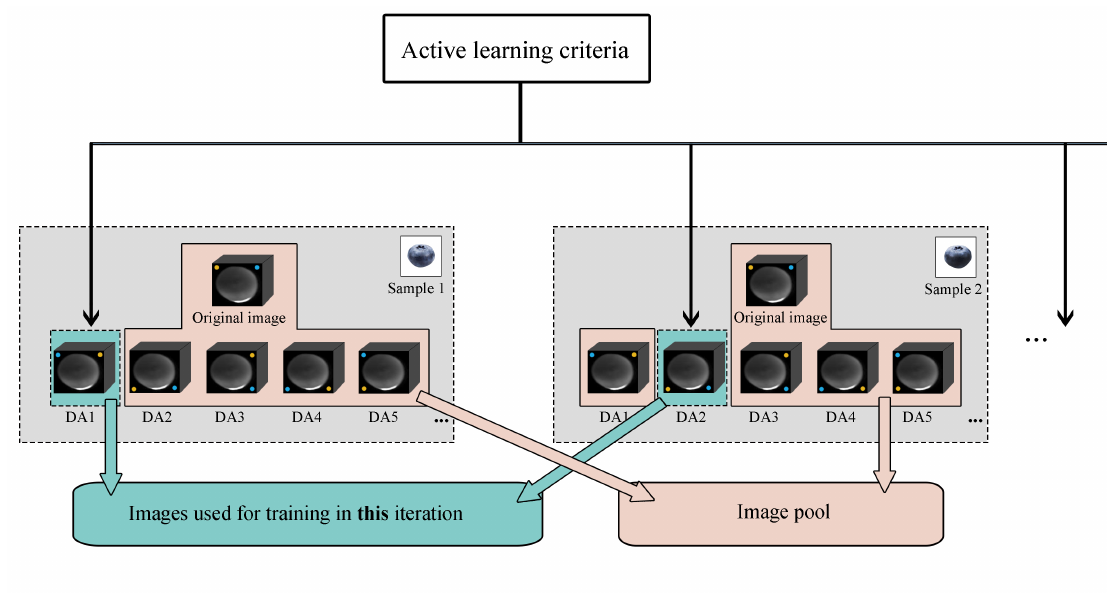
Figure 2. The principle of the image pool. “DA1”, “DA2”, etc. in the figure represent images generated by different data augment methods. Images in the image pool are used for the training in next